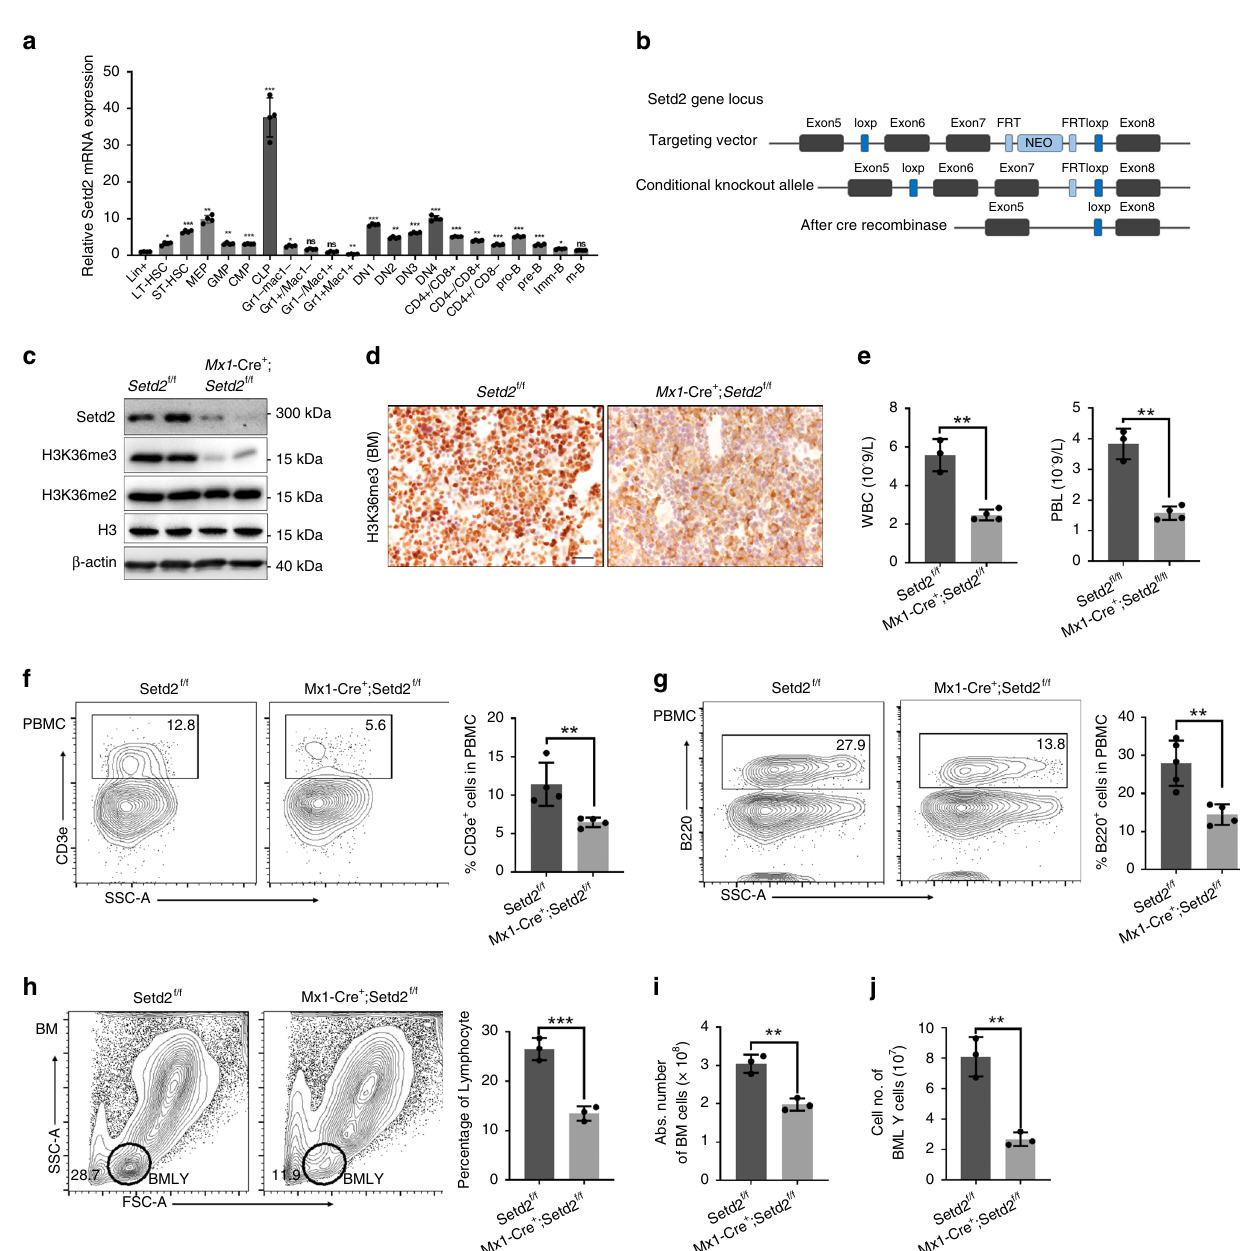
Fig. 1 Setd2-de fi cient mice exhibit reduced numbers of T and B lymphocytes. a Relative mRNA expression of Setd2 in different hematopoietic cell compartments ( n = 4). b Schematic of the strategy for establishing the Setd2 f/f mouse line. c Immunoblotting of Setd2 and H3K36me3 in bone marrow nucleated cells (BMNCs) from Setd2 knockout mice. H3 and β -actin were used as the loading controls. d Immunohistochemistry of H3K36me3 in femur sections from Setd2 knockout and control mice. e Complete blood count of peripheral blood showed lymphopenia in pIpC-treated Mx1-Cre + ;Setd2 f/f mice. (WBC, white blood cell; PBL, peripheral blood lymphocyte; n = 7). f , g Flow cytometric analysis of CD3e + T cells ( f ) and B220 + B cells ( g ) in the peripheral blood of Setd2 knockout and control mice ( n = 8 – 9). h – j Flow cytometric analysis of bone marrow and bone marrow lymphocytes (BMLYs) in Setd2 knockout and control mice. ( n = 6). (Data were collected at 8 weeks after the fi nal pIpC injection. The data are presented as the means ± SDs. * p < 0.05; ** p < 0.01; *** p < 0.001; ns, not signi fi cant, Source data are provided as a Source Data fi